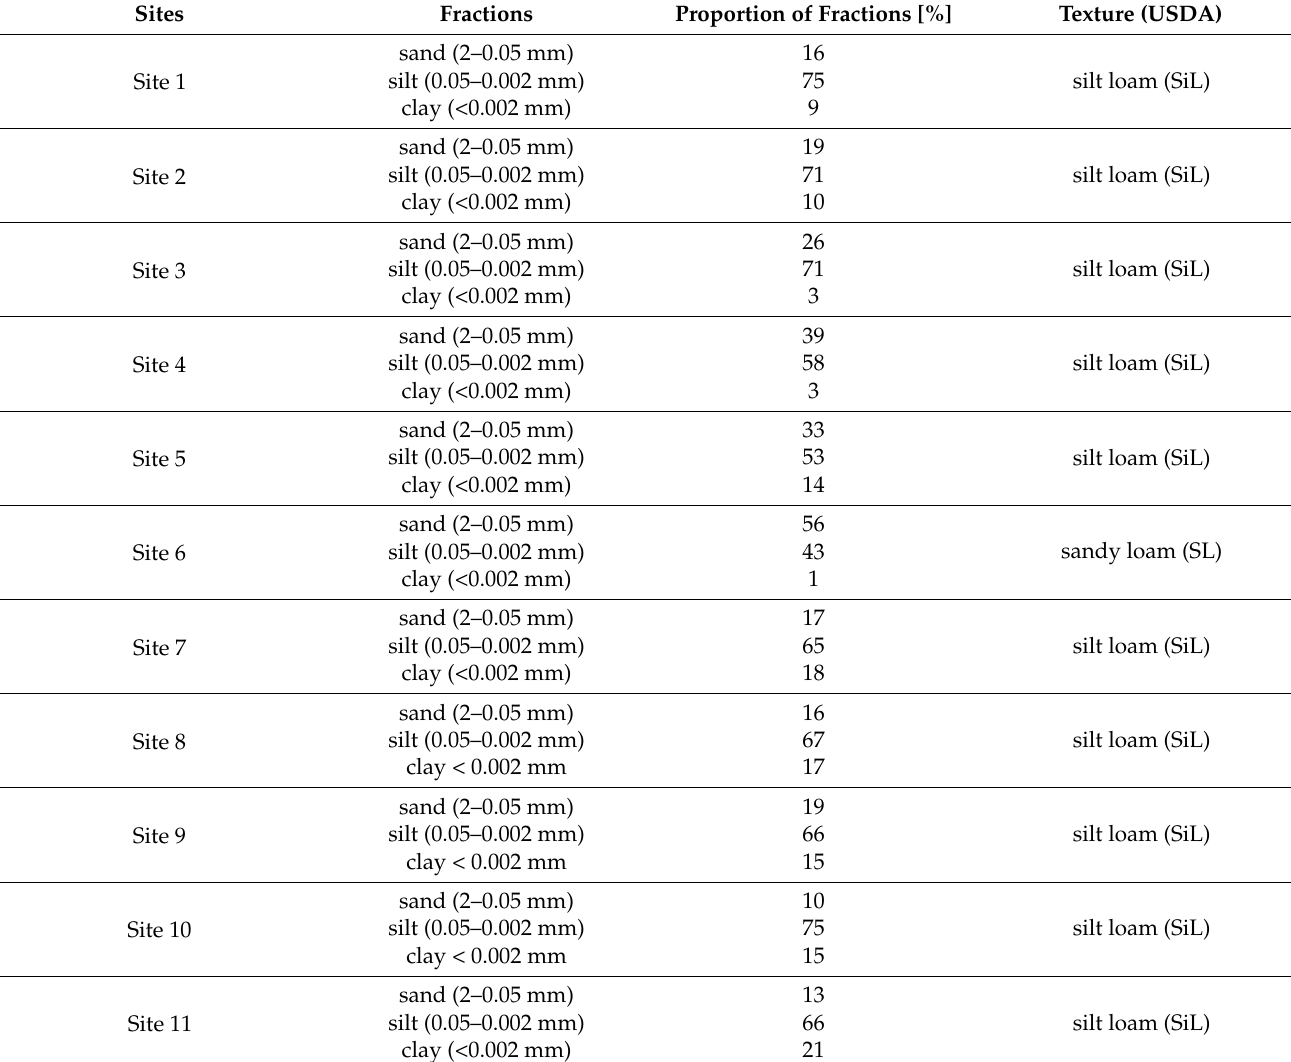
Table 2. Division of mineral deposits into granulometric subgroups according to the percentage of sand, silt and clay fractions of soil samples taken from test